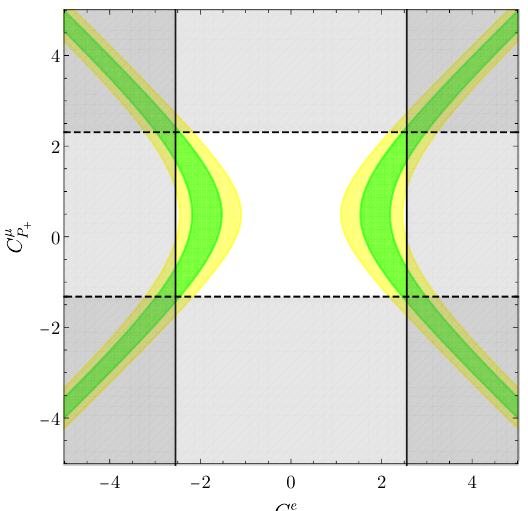
Figure 2. Parameter space for R K , for an ALP heavier than B mesons. In yellow and green are respectively depicted the 1 σ and 2 σ solutions to the central bin of R frame of the figures are excluded at 2 σ by data on semileptonic B → Ke + e − (solid black contours) and B → Kµ + µ − (dashed black contours)